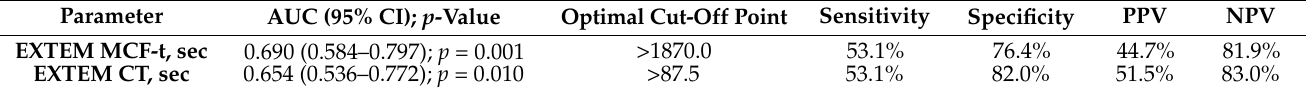
Table 5. Accuracy of postoperative day-1 thromboelastometric studies in predicting EAD